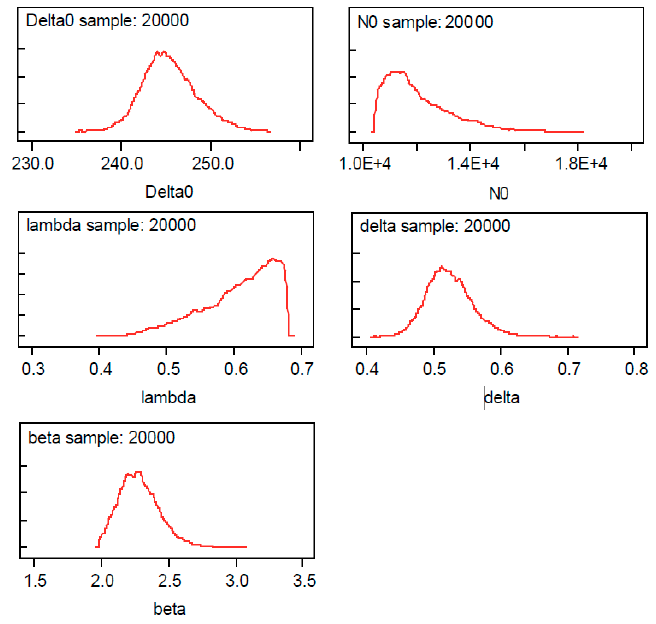
Figure 7. Posterior distributions of the model parameters fitted to the Maennig data.